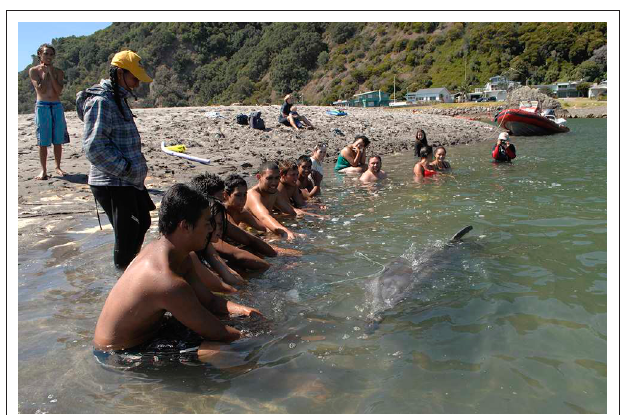
FIGURE 8 | “Moko” the solitary-sociable dolphin interacting with the public under the supervision of his guardian (wearing the yellow cap) (Photo: Ingrid